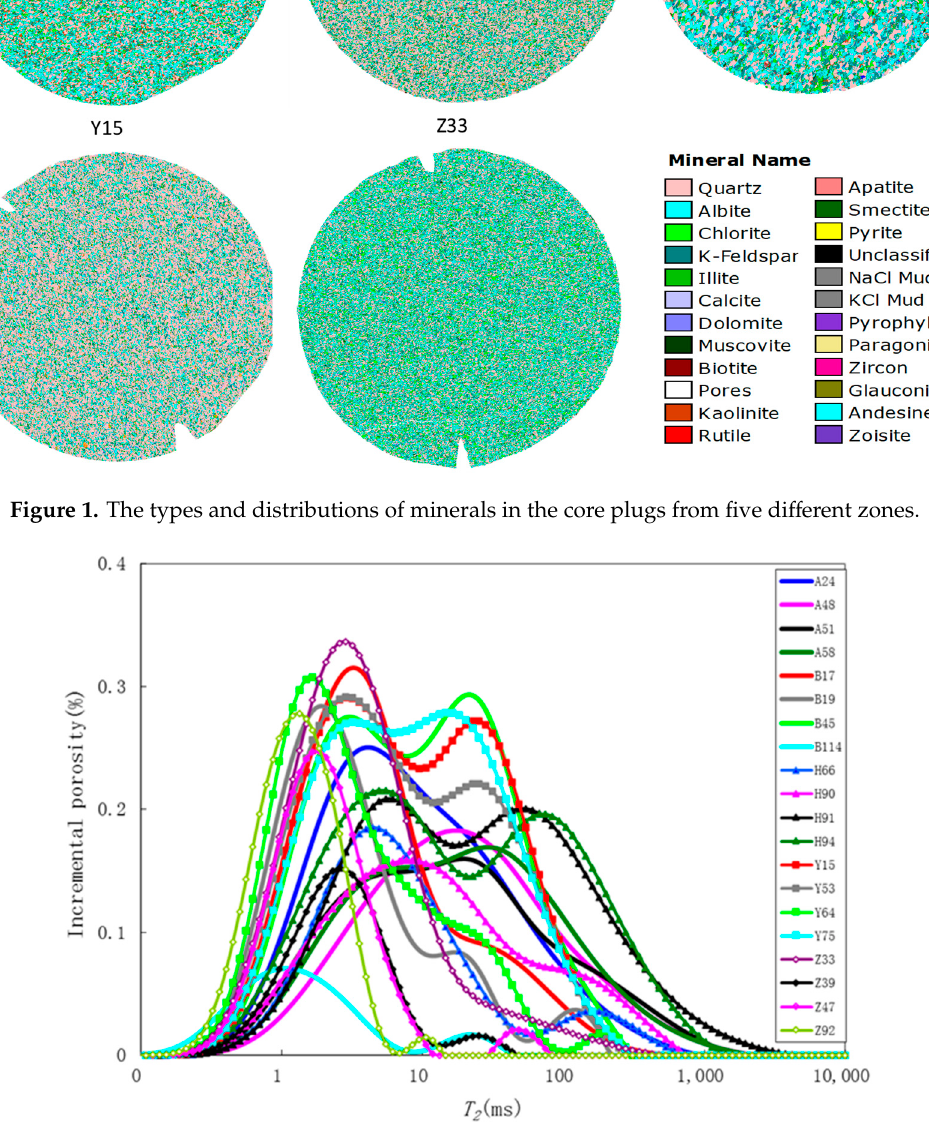
Figure 2. Nuclear magnetic resonance (NMR) T 2 spectra of 20 core plugs. 136